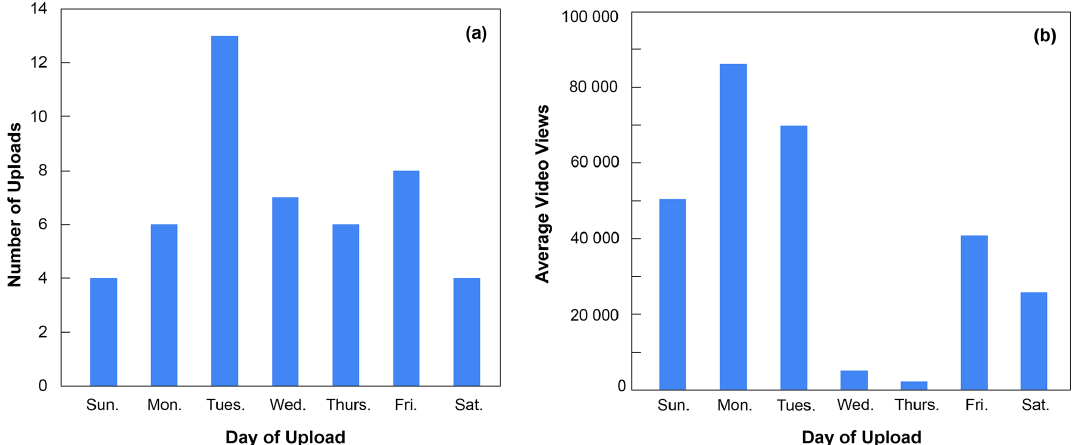
Figure 3. (a) The number of videos uploaded per day of the week. (b) The average total number of video views received based on the day of video upload. Videos that were posted on Wednesdays and Thursday received the lowest number of views on